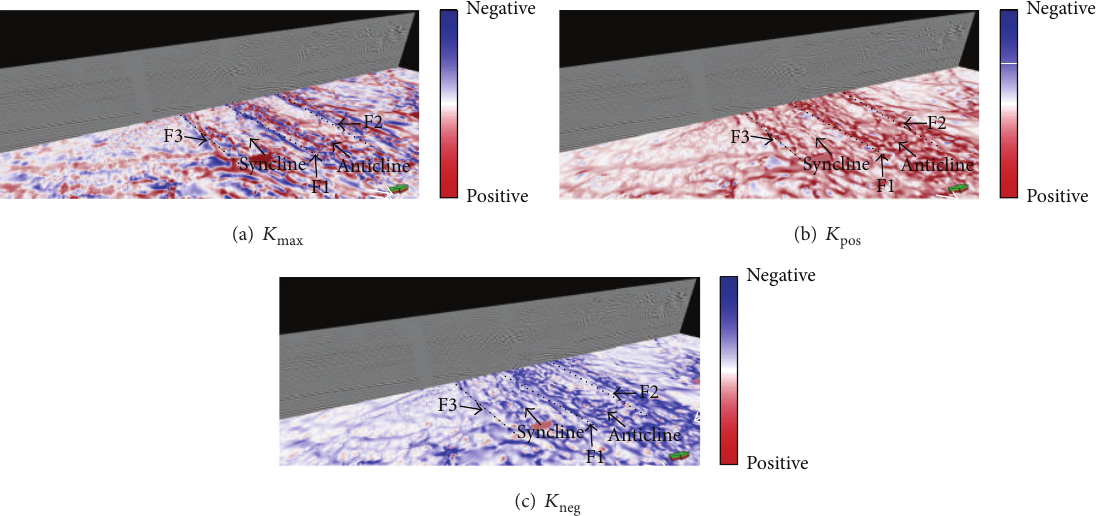
) , and (c) most-negative curvature (𝐾 ) showing anticlinal and pos neg